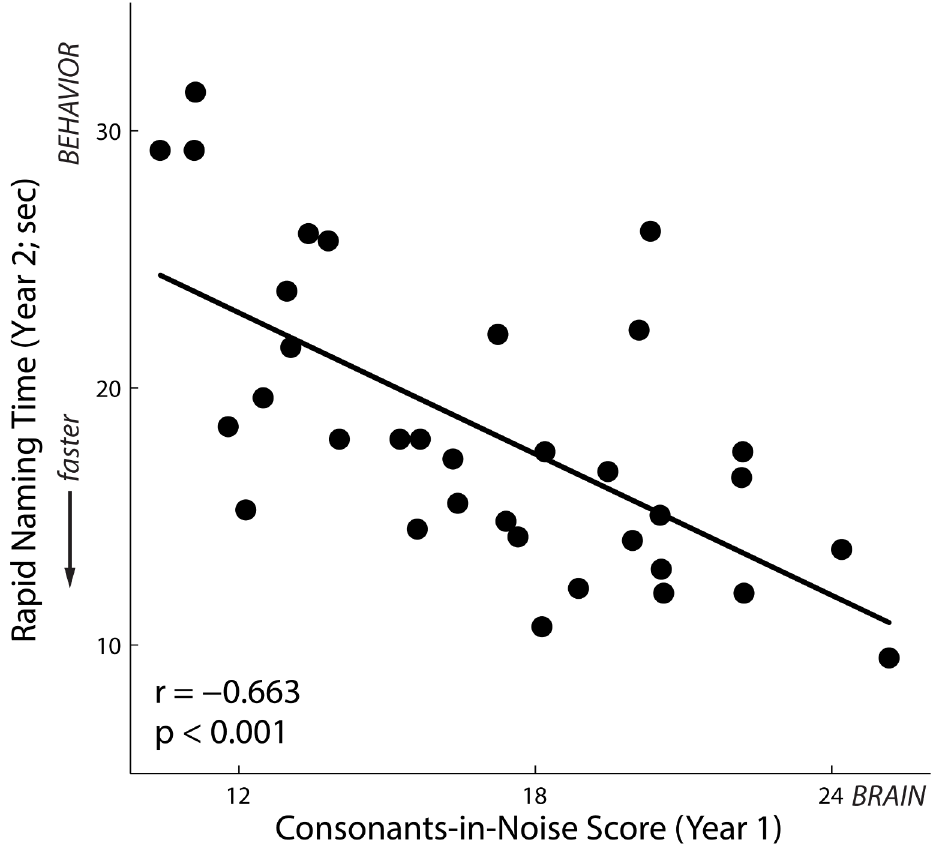
Fig 3. In preschoolers ( n = 34), model predictions of phonological processing in Year 1 (based on auditory neurophysiology) predict rapid automatized naming time in Year 2, with higher predicted scores correlating with faster naming times for objects and colors ( r = -.663, p < .001). Please refer to the S1 Data for data underlying this